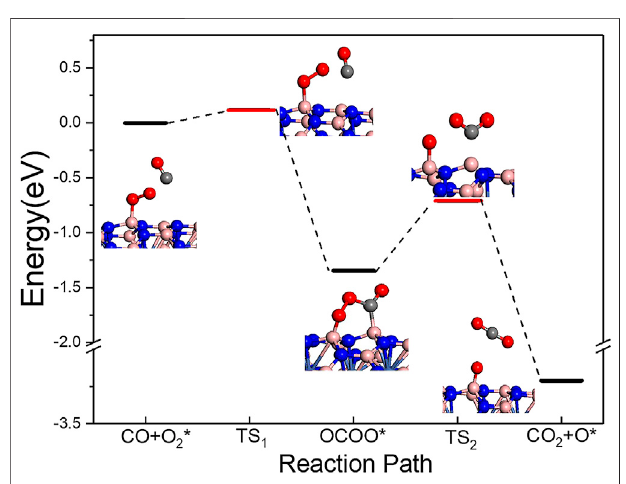
FIGURE 3 | CO and O 2 coadsorption structures with CO adsorbed on BN(9.0)/Ni. The values below are the adsorption energyof CO molecules after O 2 pre-adsorbed. (E) Two reaction pathways ofCO oxidation on BN(9.0)/Ni startingfrom (D)